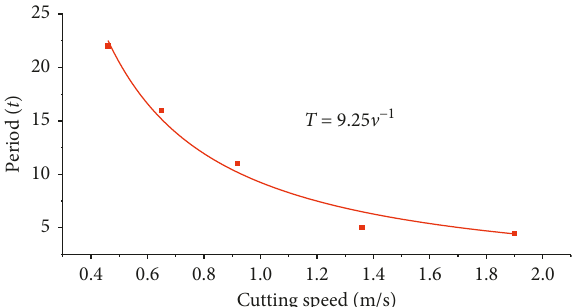
Figure 12: The influence of cutting speed on the stress fluctuation cycle period ( α